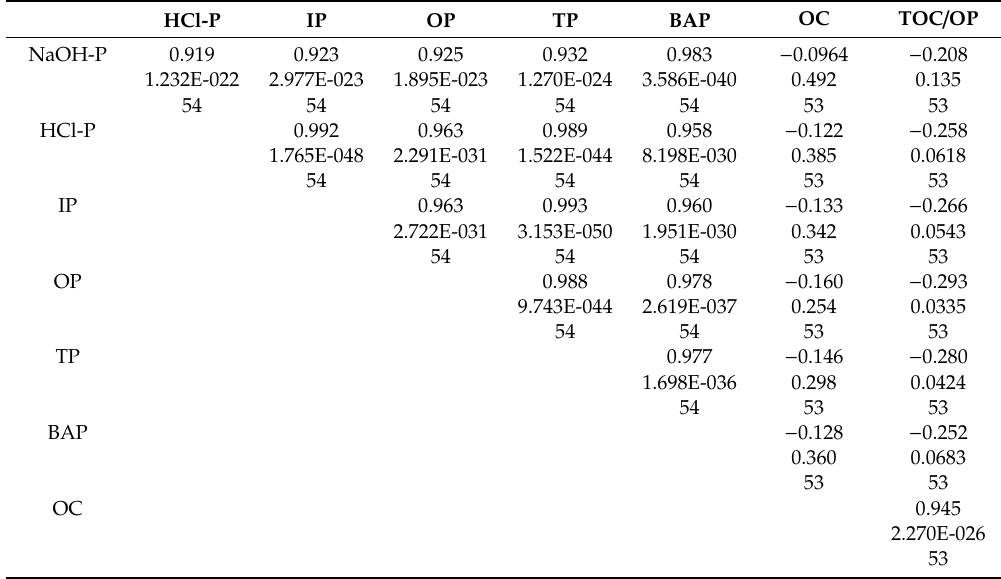
Table A5. Correlation analyses among the P species and some lignin and elemental